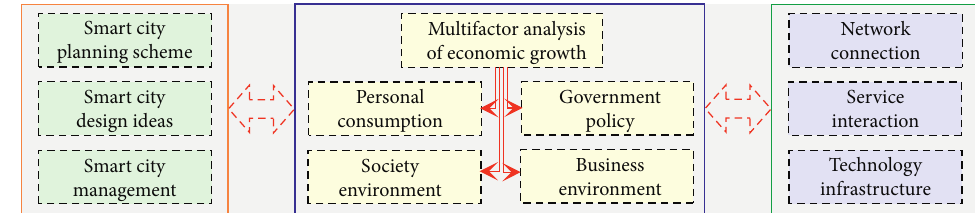
Figure 5: Multifactor analysis of economic growth in the context of smart city construction.